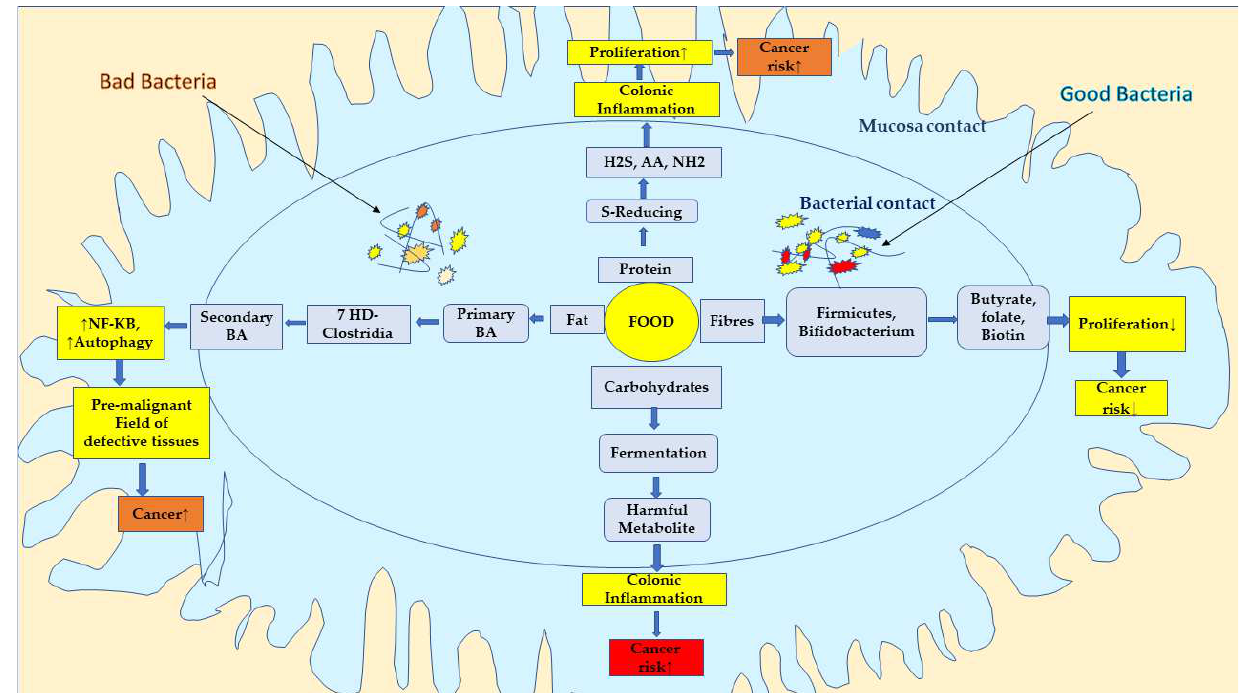
Figure 2. The association and role of bile acid, proteins, and high fat in cancer progression. Food acts differently under the influence of various microbiota as good and bad bacteria, and their effect on the progression of colorectal cancer. With an imbalanced high-fat, high-meat, low-fibre diet, the proinflammatory and proneoplastic properties of protein fermentation and bile acid deconjugated residues predominate, leading to increased colon cancer risk. H2S: Hydrogen sulphide, AA: Amino acid, NH2: Amines, BA: Bile acid. ↓ ; decreasing, ↑ :